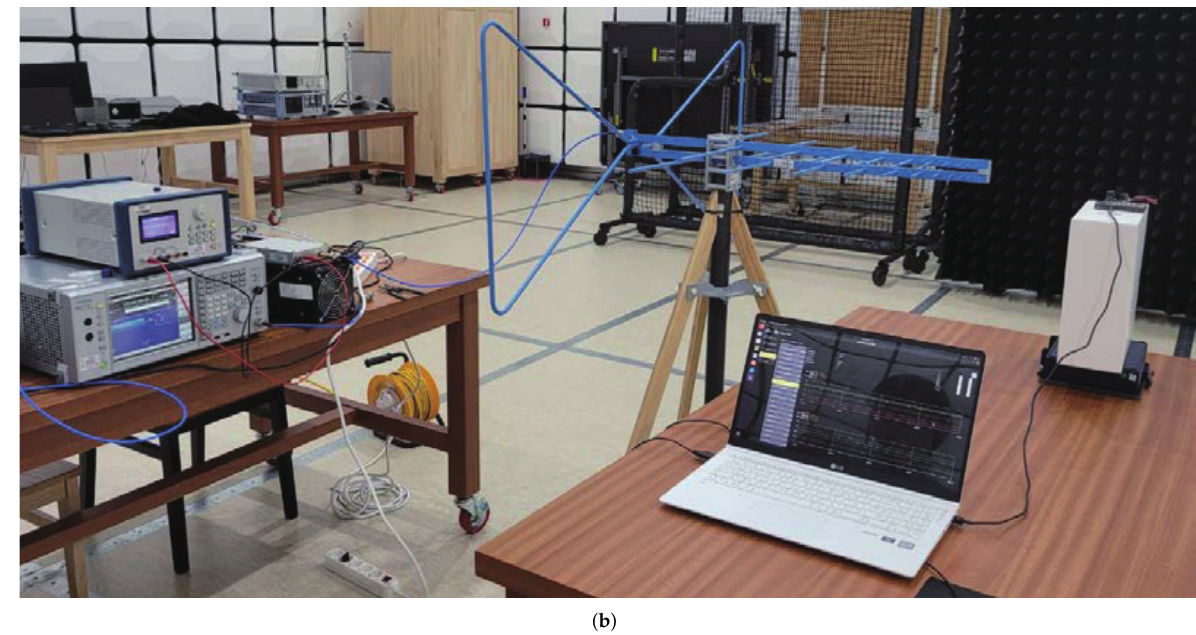
Figure 6. Experimental setup for high power IEMI experiments. ( a ) Experimental setup diagram; ( b ) Realized experimental setup.